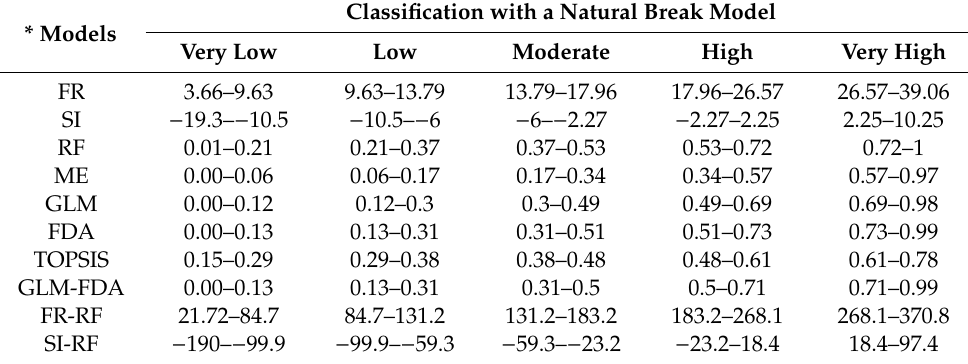
Figure 7. Percentage of each susceptibility classes in individual and hybrid models. Figure 8. Area under curve in individual and ensemble models. ( a ) training data (success rate curve), ( b ) validation data (prediction rate curve).